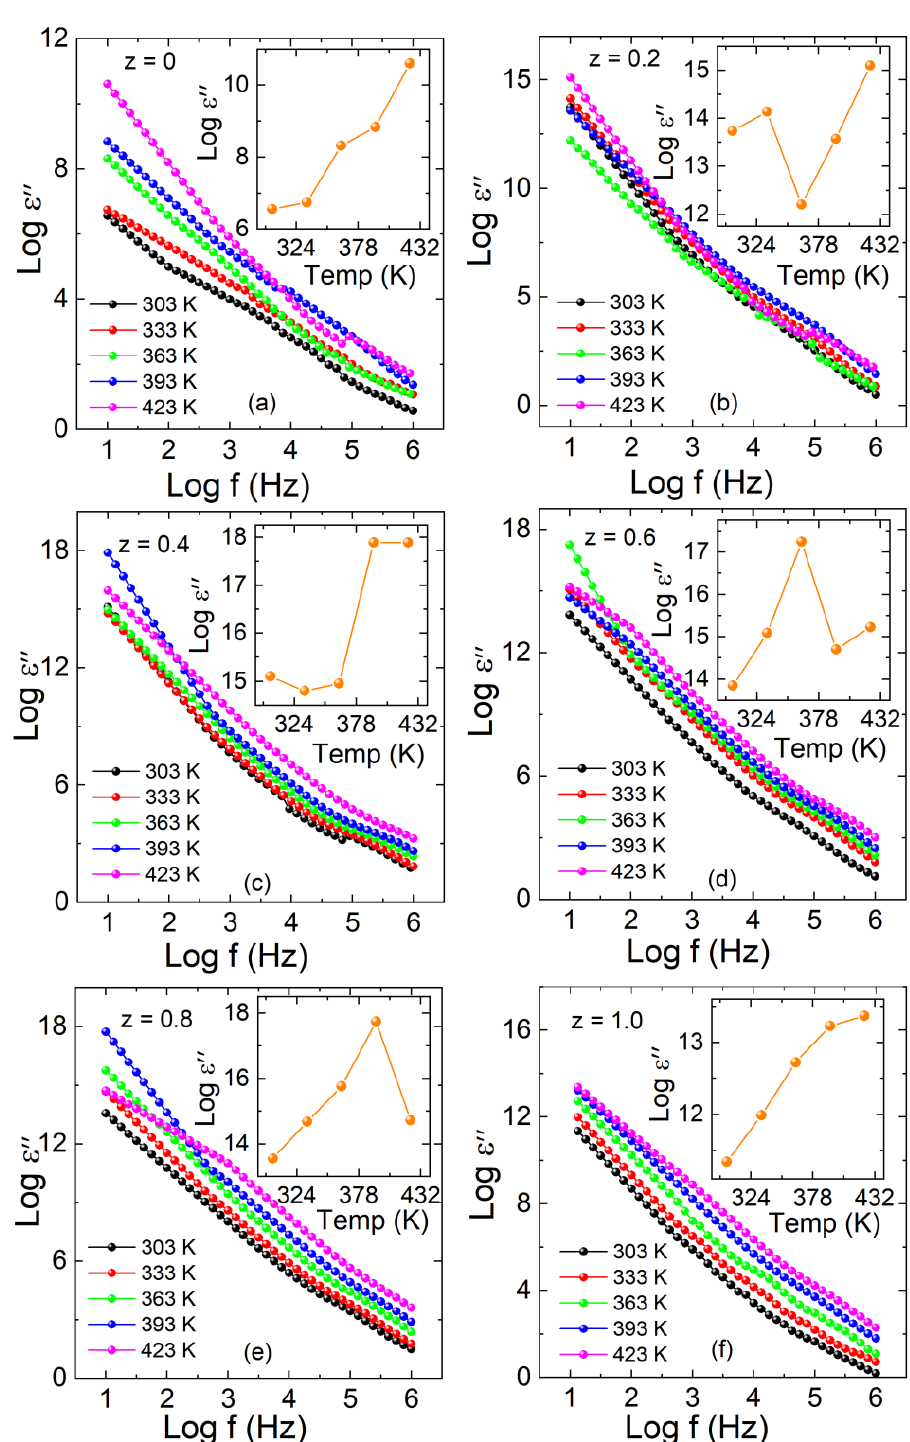
Figure 8. ( a – f ) Imaginary part of dielectric ( Log ε ” ) versus Log f graph for La 2 Co 1 − z Fe z MnO 6 (z = 0, 0.2 – 1.0). Inset of ( a – f ) represents the temperature-dependent imaginary part of each plot.